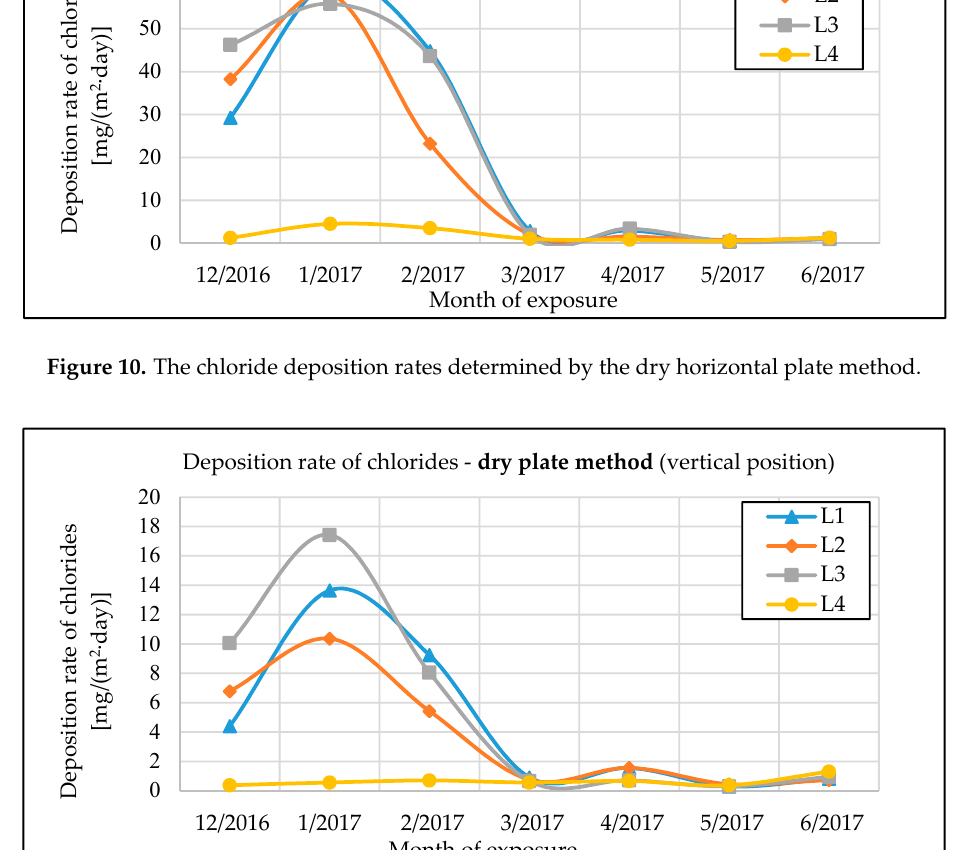
Figure 11. The chloride deposition rates determined by the dry vertical plate method.